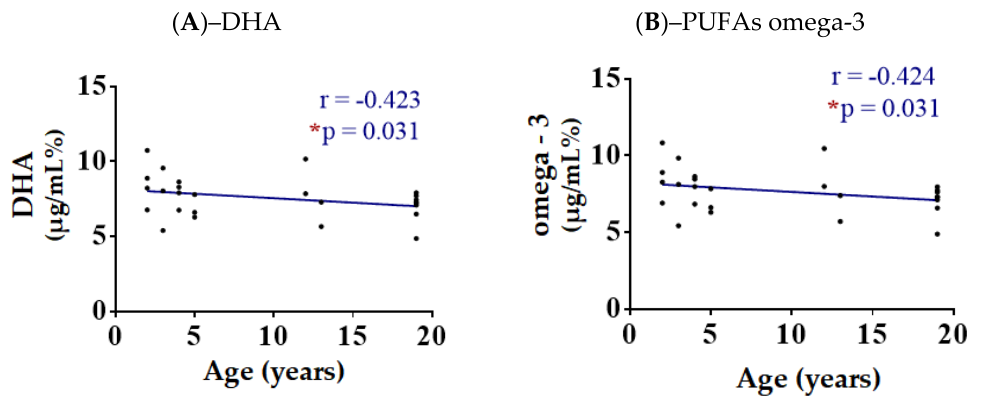
Figure 1. Spearman correlation with linear regression and parameters for 26 healthy donkeys using age and lipid indexes obtained from spermatozoa membranes. Values significantly different when compared to with each other: (*) p < 0.05. Significant decreased levels of DHA ( A ) as well as PUFAs omega-3 ( B ) with the increase in the age of the donkeys.